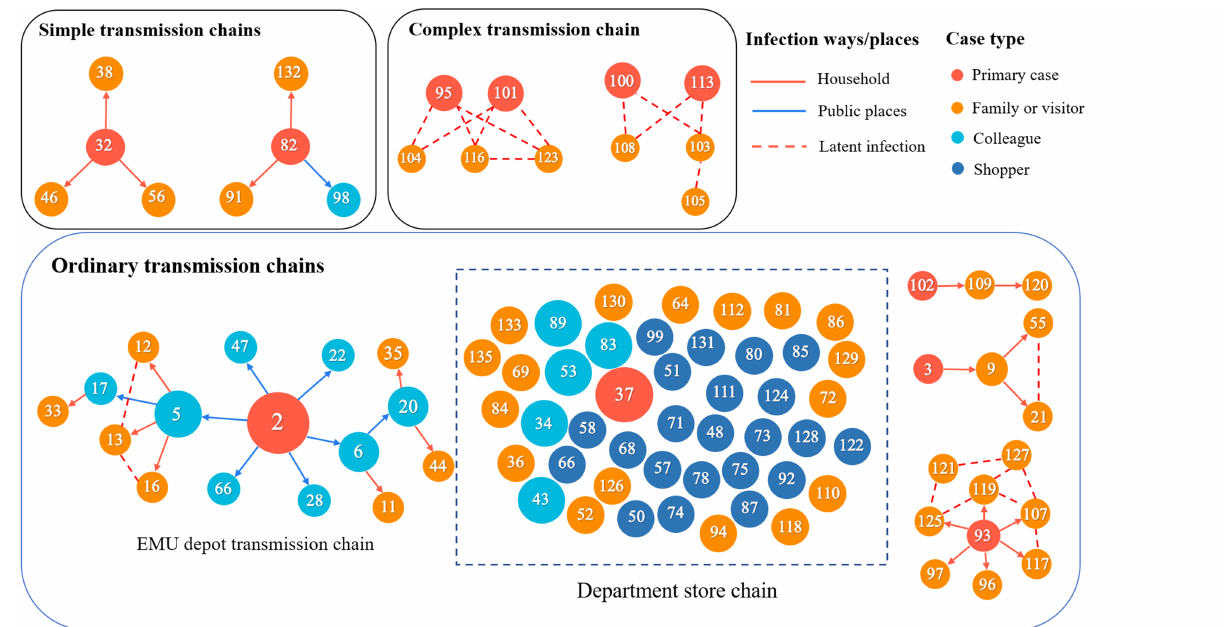
Figure 2. Reconstructed transmission chains (excepted for isolated cases) of COVID-19 outbreak in Tianjin by 26 February 2020. The red circles represent the primary cases in each chain, the orange circles are the family members or visitors, and the blue circles are the colleagues. The red arrows and the blue arrows represent the transmissions within household and in public places, respectively. The dash lines represent latent epidemiological links. Besides, the dotted box indicates that all cases in the department store chain have the potential to infect others.